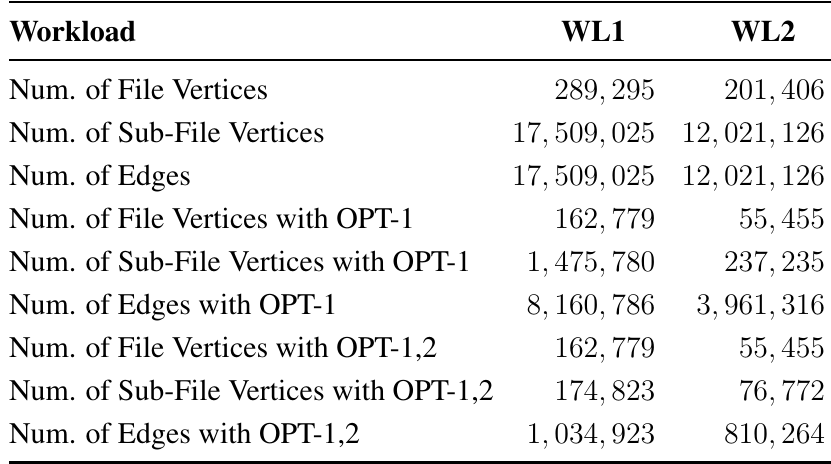
Table 5. Graph characteristics after applying optimization 1 and 2 in GraphOpt for two